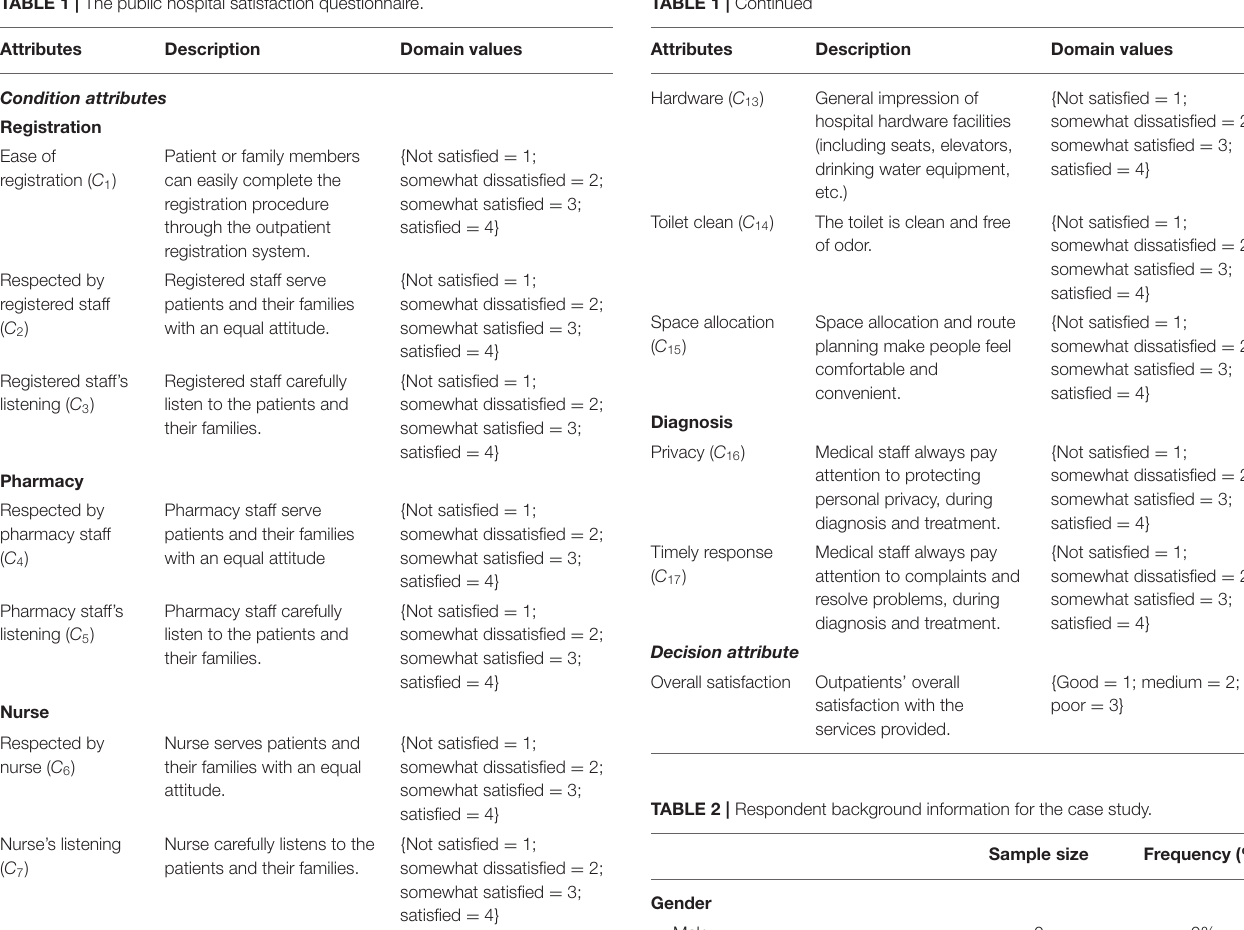
TABLE 1 | The public hospital satisfaction questionnaire.